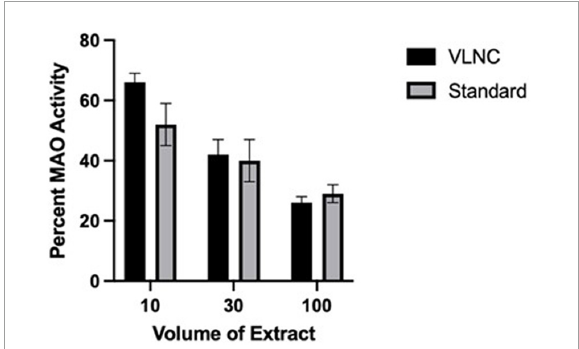
FIGURE1 MAO inhibition by Spectrum VLNC cigarette extract. Aqueous cigarette smoke extract was produced using Spectrum cigarettes nicotine content of 0.4 and 15.8 mg nicotine per gram of tobacco, using a method modified from Gellner et al. (2016a,b). Extracts were prepared from individual cigarettes by bubbling smoke through a 10 ml column of water 8 cm high in 15 ml conical bottom test tubes. 40 ml of smoke was drawn